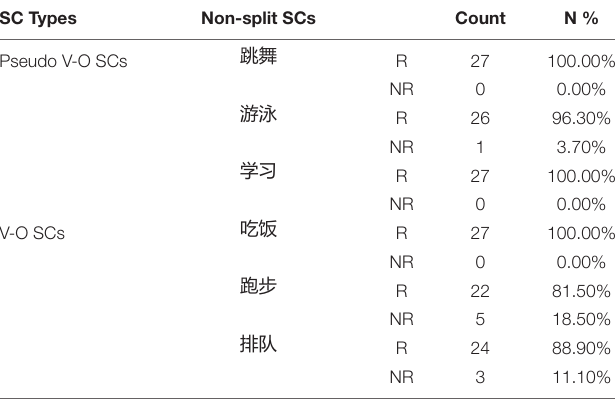
TABLE 4 | Recognition of non-split